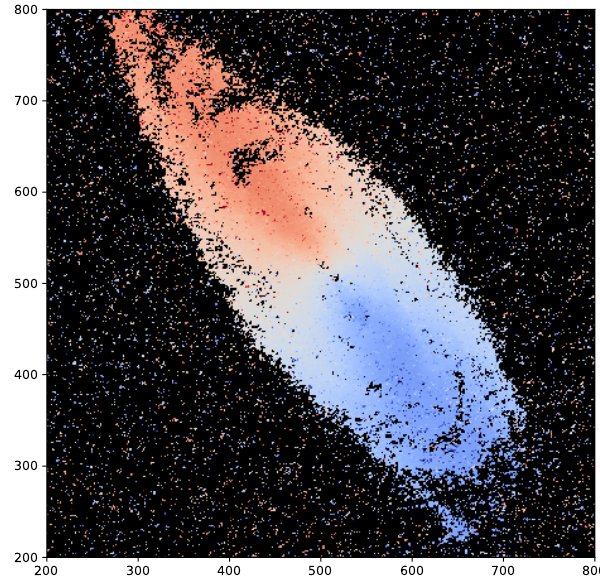
Fig. 23.— Velocity map for the galaxy NGC 3198, from the THINGS survey (Walter et al. 2008),